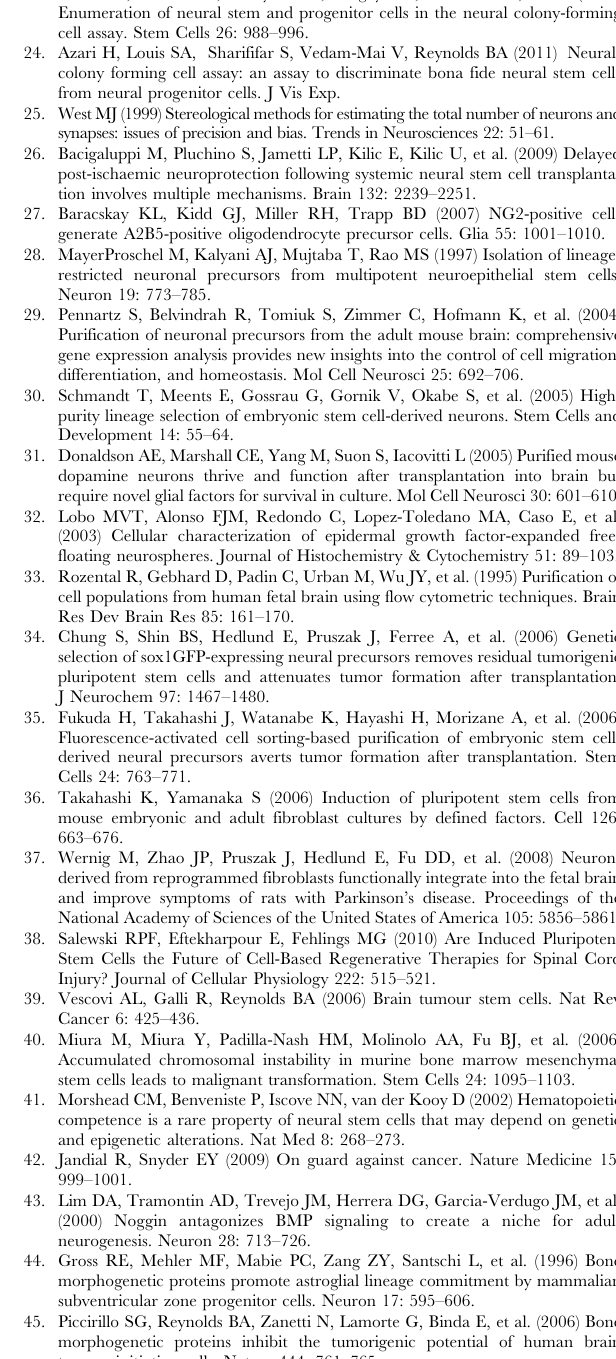
Figure S9 Sorted P1 cells do not differentiate into astrocytes after implantation into the adult mouse striatum. ( A–C ): Representative confocal micrographs show that implanted BMP4 treated P1 neuronal cells ( A , green) survive but do not differentiate into GFAP expressing cells ( B , red) as evident in the merged picture ( C ). Scale bar = 20 m